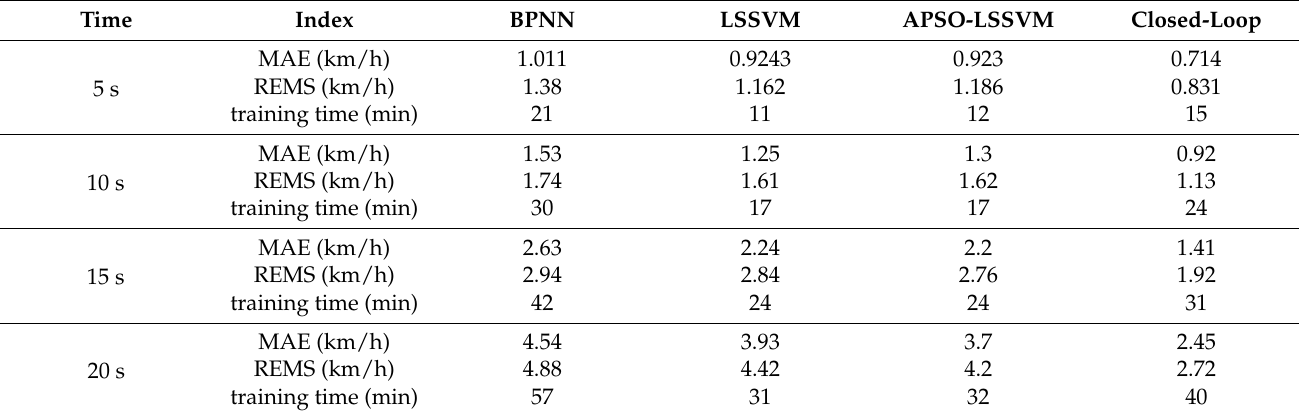
Figure 9. Partial magnification of speed prediction results. ( a ) Vehicle speed prediction; ( b ) Vehicle speed prediction error. Table 5. The assessment at different time